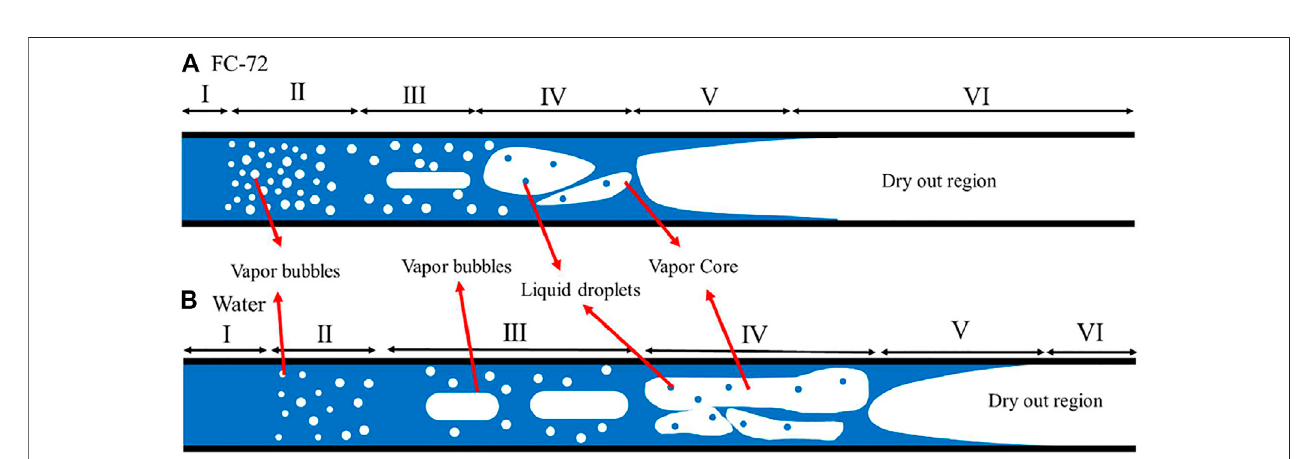
FIGURE 9 | Different fl ow boiling patterns in: (A) FC-72 medium and (B) water medium.